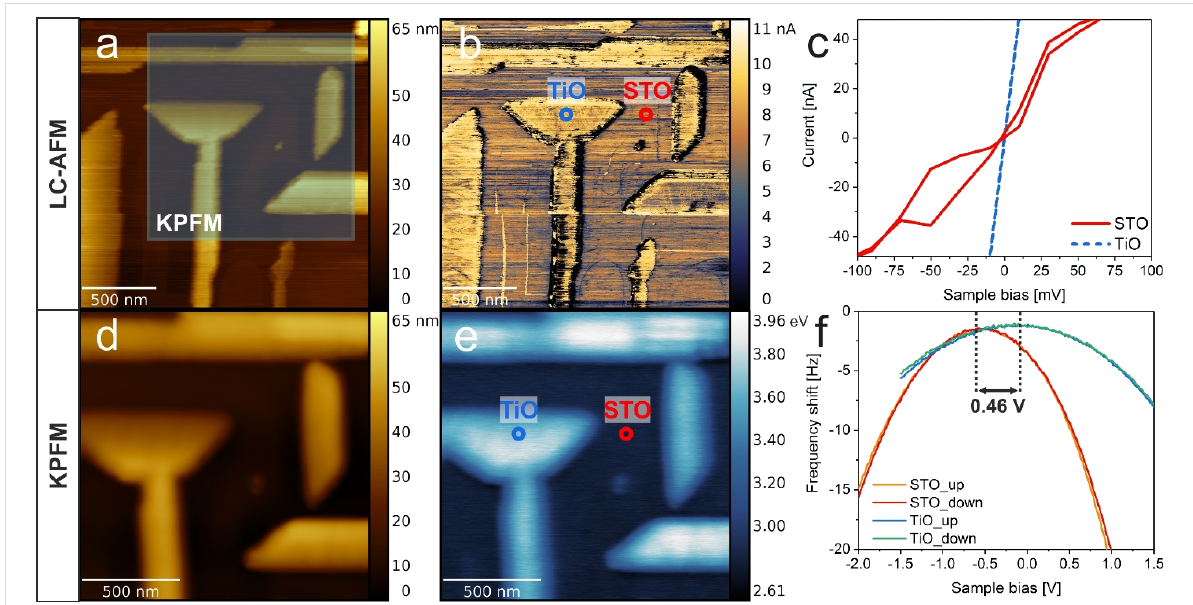
Figure 2: Electrical properties of TiO/SrTiO 3 (100) heterostructures. a), b) LC-AFM topography and current (PtIr-coated PPP-ContPt tip, +1 mV sam- ple bias), c) I – V characteristic (up and down sweeps) of marked areas on a TiO nanowire and SrTiO 3 (STO) surface, d,e) KPFM topography and work function measurement of the very same area, and f) Kelvin parabola at the same TiO and STO structures.